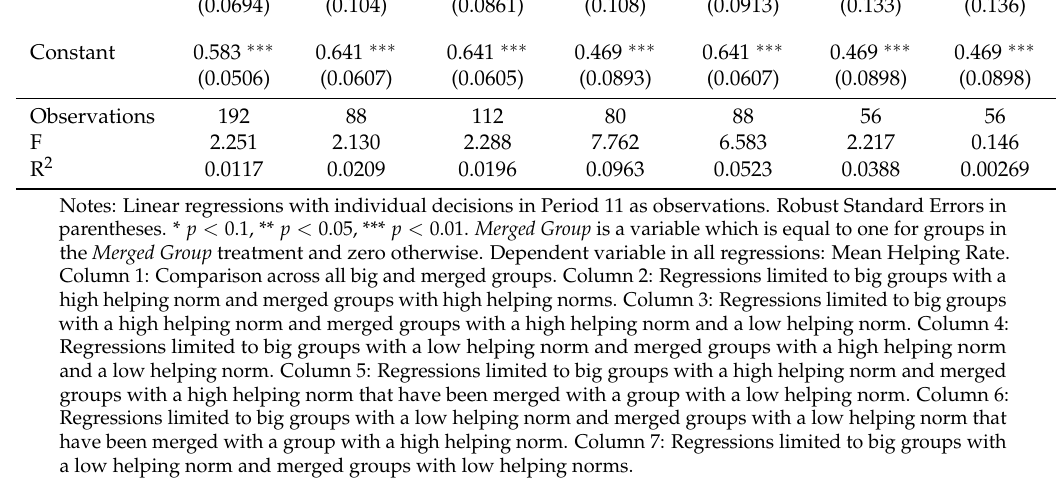
Table A16. Linear regressions: helping Rates in period 11—merged group treatment